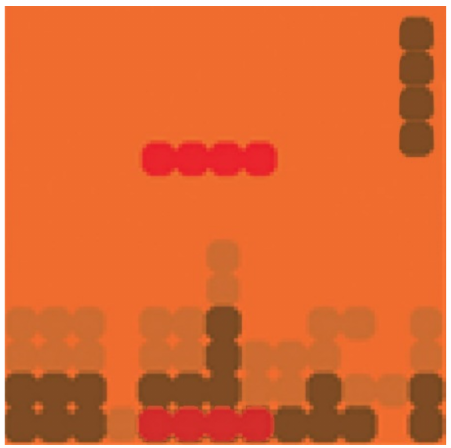
Figure 2. Illustration of falling blocks. Red blocks are seen only with the amblyopic eye, green blocks are seen only with the fellow eye, and brown blocks are visible to